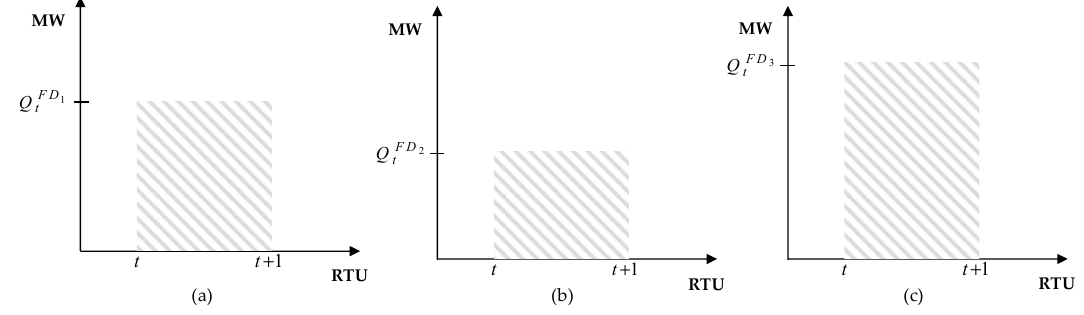
Figure 6. ( a ) Fully divisible order 1; ( b ) fully divisible order 2; ( c ) fully divisible order 3.